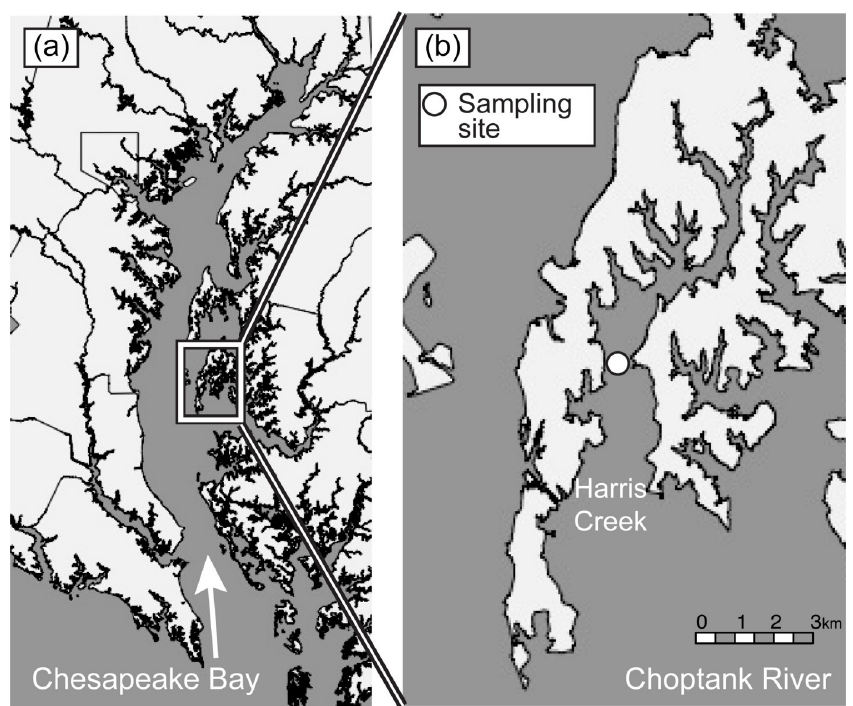
Fig 1. Map of study area. Map showing (a) the Choptank River a major tributary to the Chesapeake Bay and (b) the location of the study site ( ◯ ) within Harris Creek (Map was created in R).